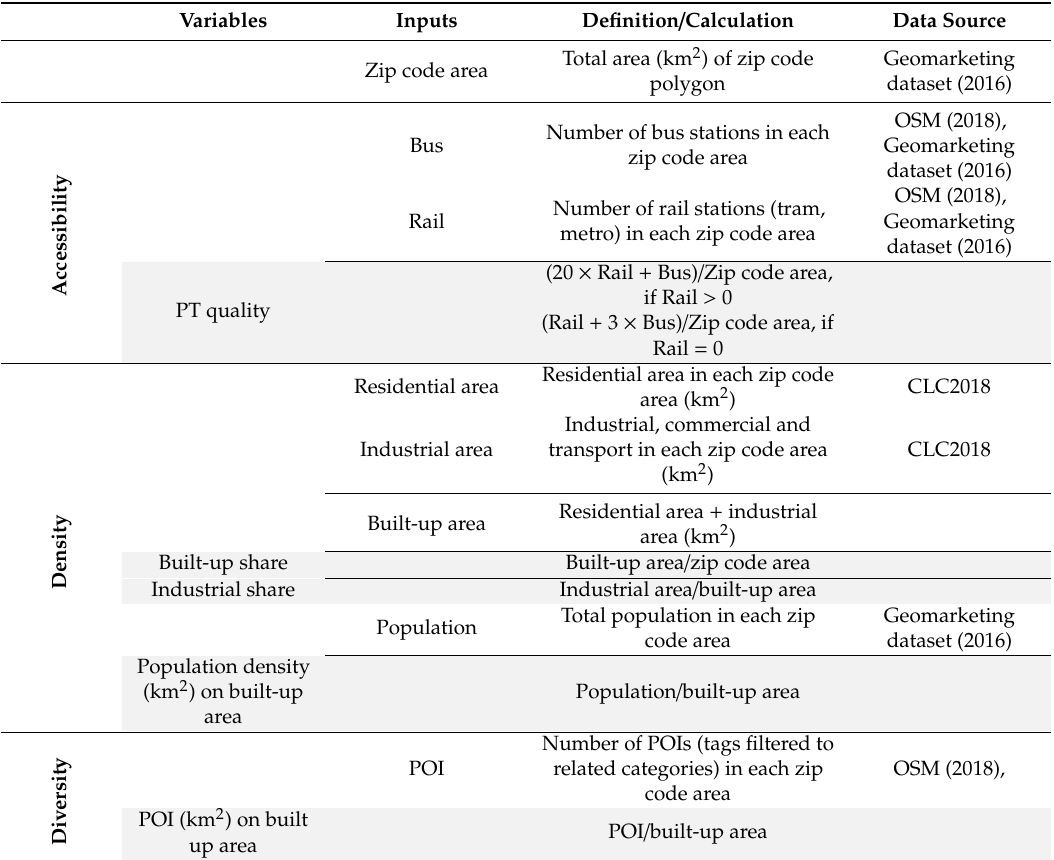
Table 2. Description of variables to define